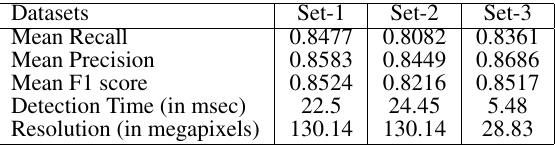
Table 1. Performance Results of Proposed Moving Cloud Detection